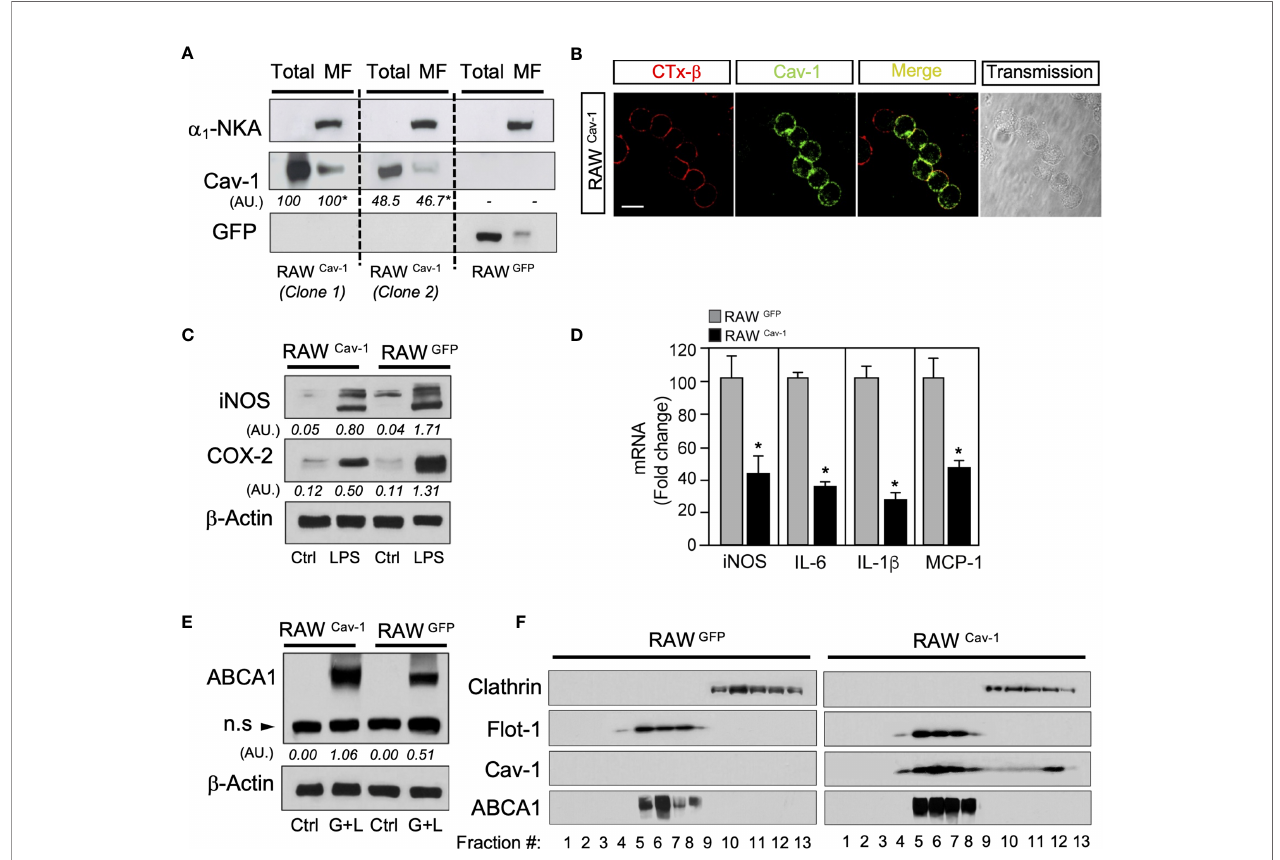
FIGURE 1 | Caveolin-1 expression modulates in fl ammatory genes and ABCA1 expression in RAW264.7 cells. (A) Western blot analysis of ectopically expressed Cav-1 in RAW264.7 cells (RAW Cav-1 ) compared with RAW264.7 control cells overexpressing GFP (RAW GFP ). a 1-Na/K-ATPase protein was used to detect plasma membrane enrichment in microsomal preparations. Densitometric analysis of Cav-1 are shown below each blot and are referred to Total or MF in RAW Cav-1 cells clone 1. (B) Colocalization of Cav-1 with lipid rafts in the plasma membrane stained with CTx- b in RAW Cav-1 cells. Scalebar: 10µm. (C) Representative Western blot analysis of iNOS and COX-2 in RAW Cav-1 and RAW GFP cells. b -Actin was used as a loading control. Densitometric values of iNOS and COX-2 are shown below each blot. (D) qRT-PCR analysis of iNOS, IL-6, IL-1 b and MCP-1 mRNA expression in RAW Cav-1 and RAW GFP cells treated with 100ng/mL of LPS for 6 hours. Data are expressed as relative expression levels and correspond to the means ± SEM from three independent experiments performed in triplicate * P<0.05 (signi fi cantly different from RAW GFP cells). (E) Representative Western blot analysis of ABCA1 in RAW Cav-1 and RAW GFP cells in response to LXR/RXR ligands for 24h(GW3965 1µM+LG268 100nM). b -Actin was used as a loading control. Densitometric values of ABCA1 are shown below each blot. (F) Representative Western blot analysis of lipid raft fractionation in RAW Cav-1 (left panel) and RAW GFP (right panel) cells showing the expression of Cav-1 and ABCA1 in response to LXR/RXR ligands for